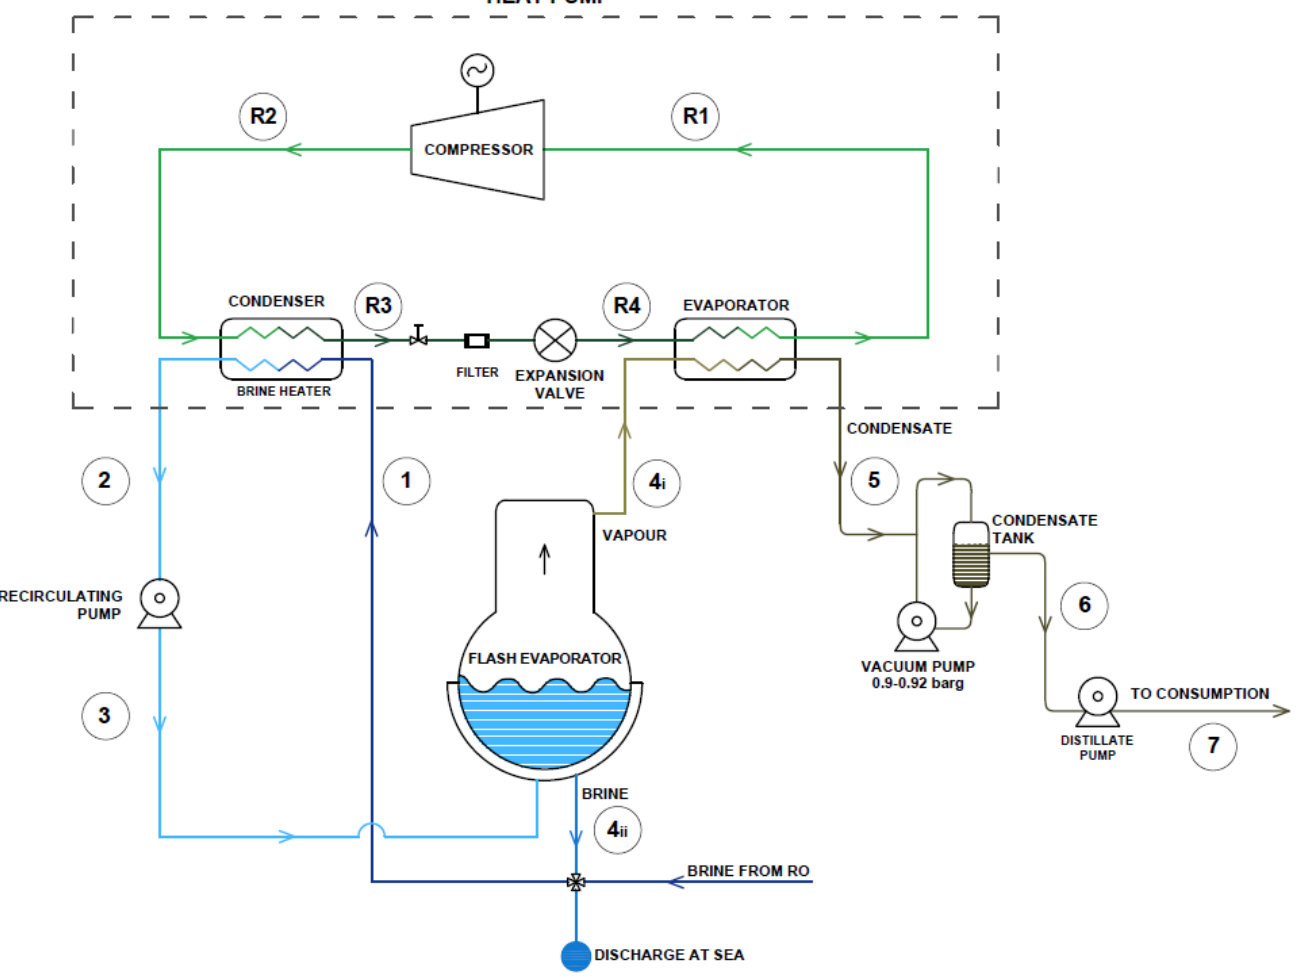
Figure 1. Desalination unit for brine